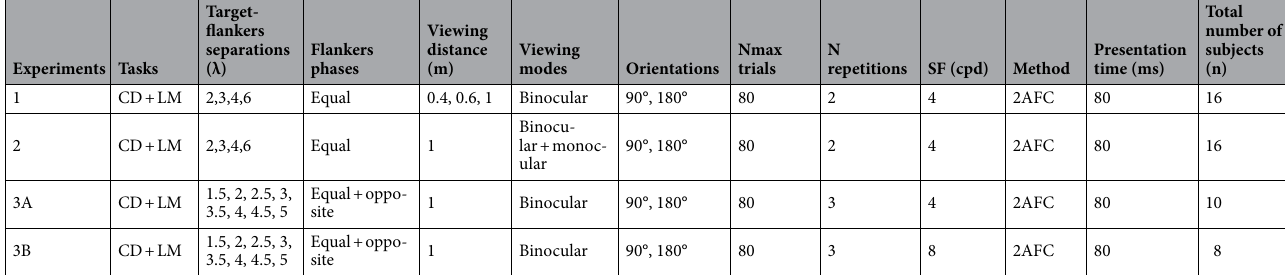
Table 2. Experimental protocols. CD contrast detection, LM lateral masking, N number, AFC alternating forced